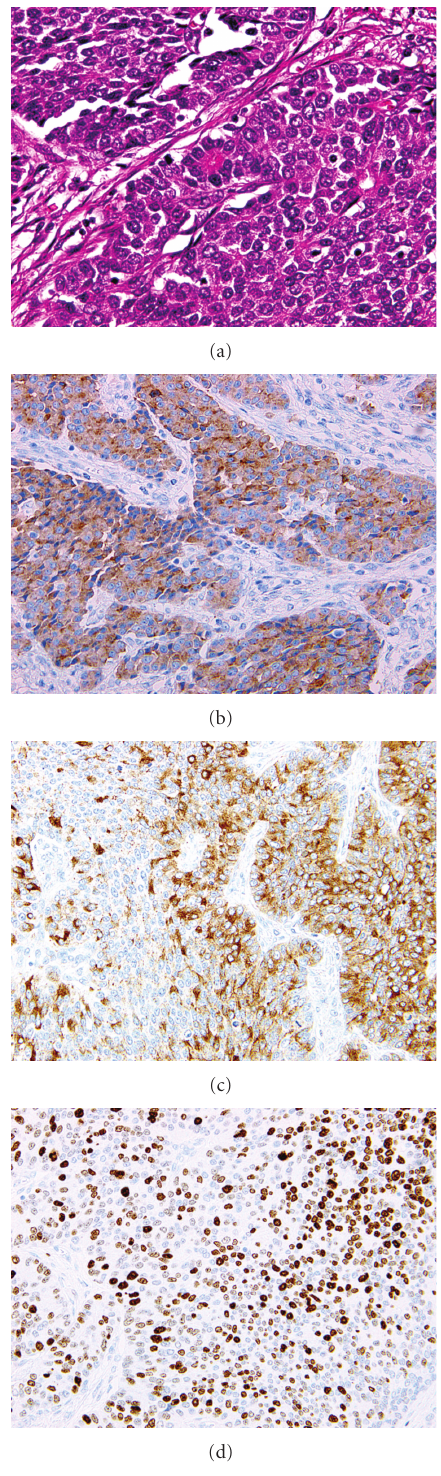
Figure 2: Histological findings of the tumor (x 400). The tumor was uniform in shape and arranged in small microtubular structures (rosette-like arrangement) to form solid nests, with medium-sized, round-to-cuboid-shaped tumor cells. The tumor cells exhibited intense mitosis greater than 2/HPF (hematoxylin and eosin, (a)). Immunohistochemical staining showed that it was positive for synaptophysin (b) and chromogranin A (c). The Ki-67 labeling index was 70–80%